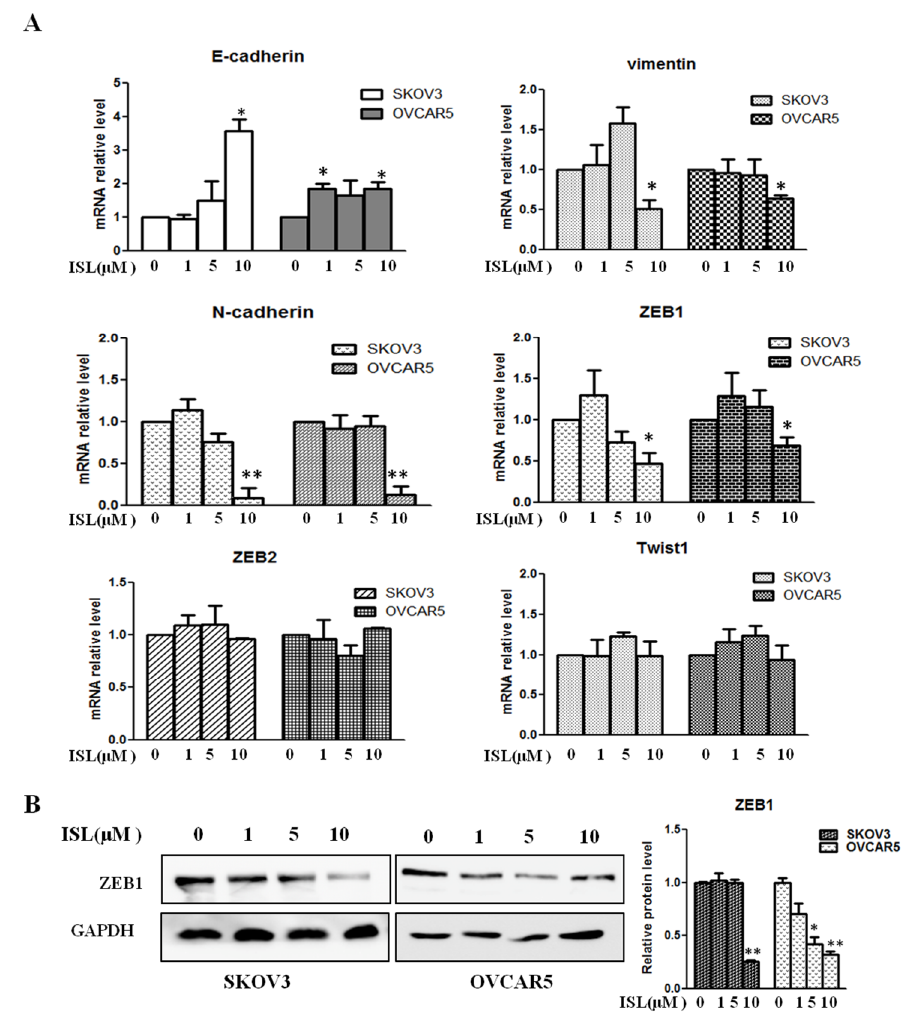
Figure 3. E ff ects of ISL on the expression of E-cadherin, Vim, N-cadherin, Twist1, ZEB1, and ZEB2 in SKOV3 and OVCAR5 cells. ( A ) Cells were treated with vehicle or ISL (1, 5, and 10 µ M) for 72 h, followed by qRT-PCR analysis. Gene expression is presented as fold changes and normalized to β -actin. ( B ) Cells were treated with ISL (1, 5, and 10 µ M) for 72 h and analyzed by Western blotting. The bar graph shows results of a quantitative data of Western blotting. Protein expression is presented as fold changes and normalized to GAPDH. Data are presented as mean ± SD. n = 3. Student t -test was used for statistical tests. * p < 0.05, ** p < 0.01 compared with the control group.